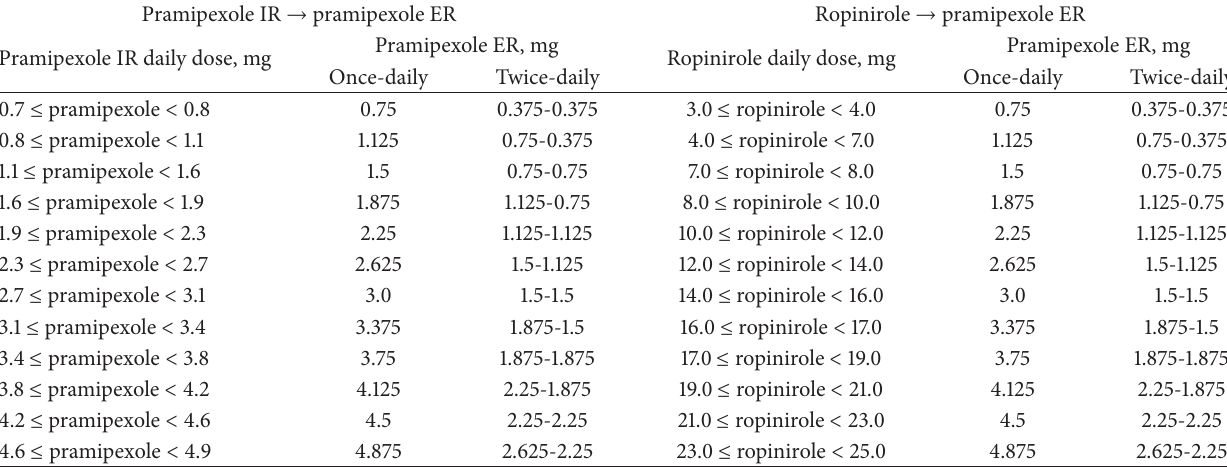
Table 2: Dose switches from conventional dopaminergic agonist to pramipexole